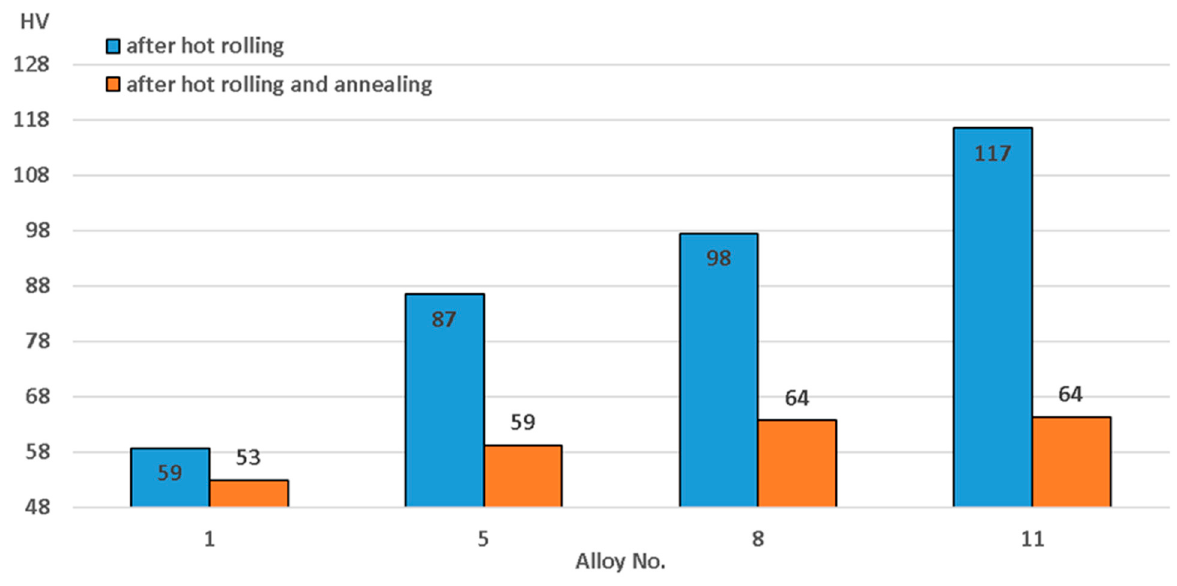
Figure 4. Changes in micro-hardness related to alloy chemical composition.